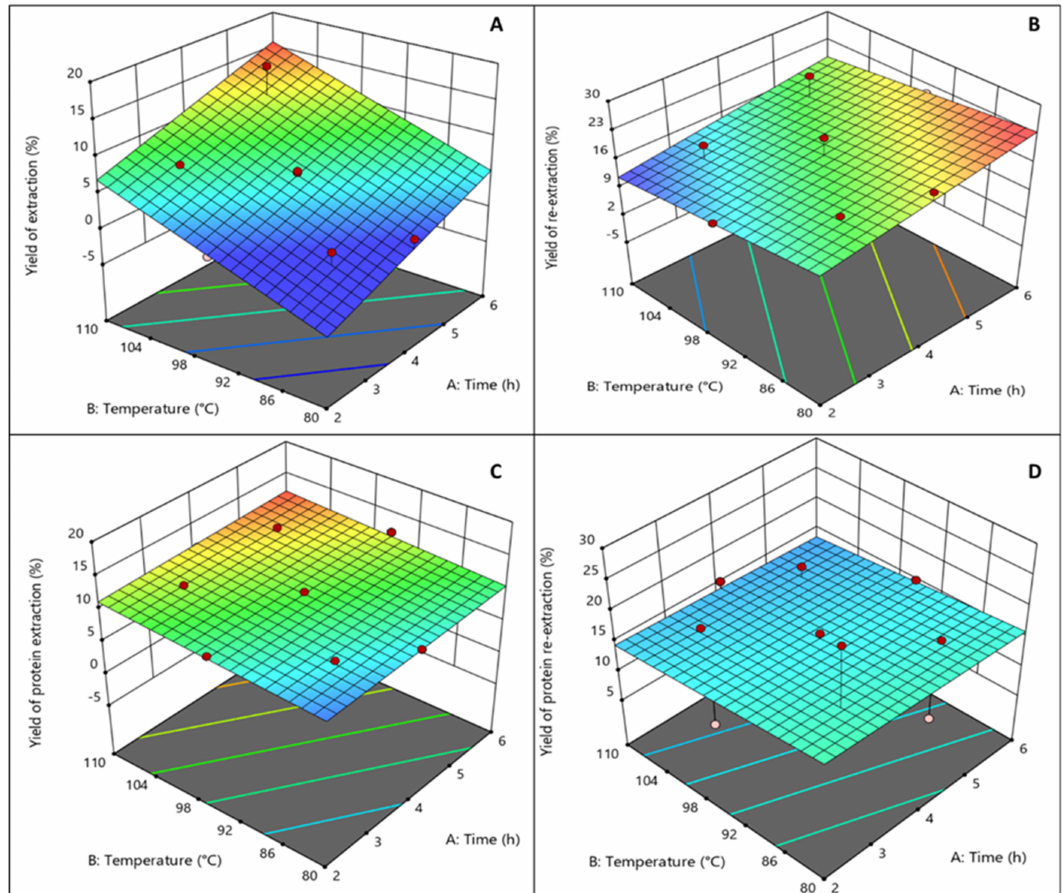
Figure 3. Design Expert 3D conventional agar extraction surface graphs (( A ) yield extraction (%), ( B ) yield re-extraction, ( C ) protein extraction (%), and ( D ) protein re-extraction